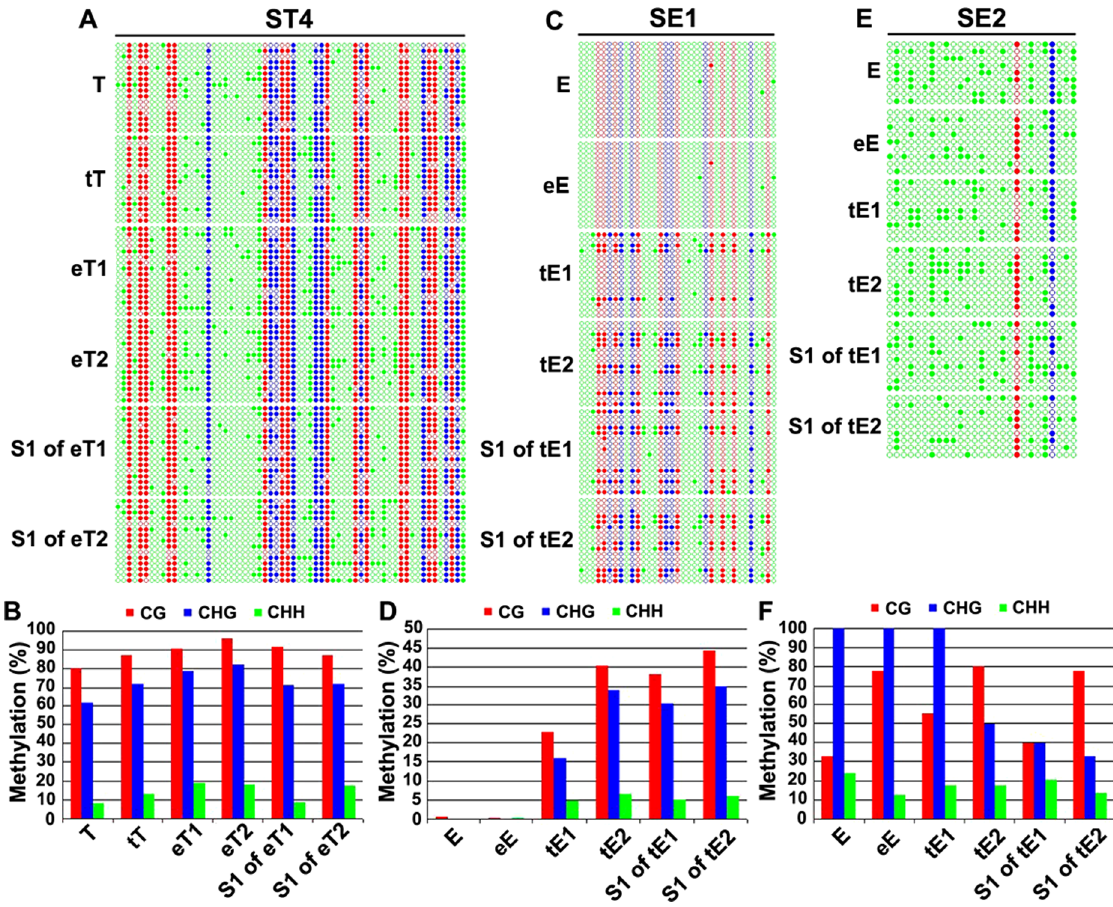
Figure 3. Validation of grafting-induced DNA methylation alterations and their inheritance by locus-specific bisulfite Sanger- sequencing. DNA methylation maps and collective methylation values (in percentage) for the three selected MSAP bands, unique-copy genic sequences ST4 (from tomato scion) (A and B) and SE1 (from eggplant scion) (C and D), and a low-copy retrotransposon fragment SE2 (from eggplant scion) (E and F), determined by genomic bisulfite Sanger-sequencing in the following samples: seed-plants of tomato (seed-plant T) and eggplant (seed-plant E), two independent, reciprocally hetero-grafted scion plants, tomato grafted to eggplant (eT1-2) and eggplant grafted to tomato (tE1-2), and one selfed progeny (S1) for each scion-plant of tomato (tT) and Eggplant (eE). All three types of cytosines, CG (red circles), CHG (blue circles) and CHH (green circles) were shown in the map. Filled and empty circles indicate methylated and unmethylated cytosines, respectively. The red, blue and green columns in the histograms refer to the collective methylation levels (in percentage) respectively of CG, CHG, and CHH for each sample, described above.